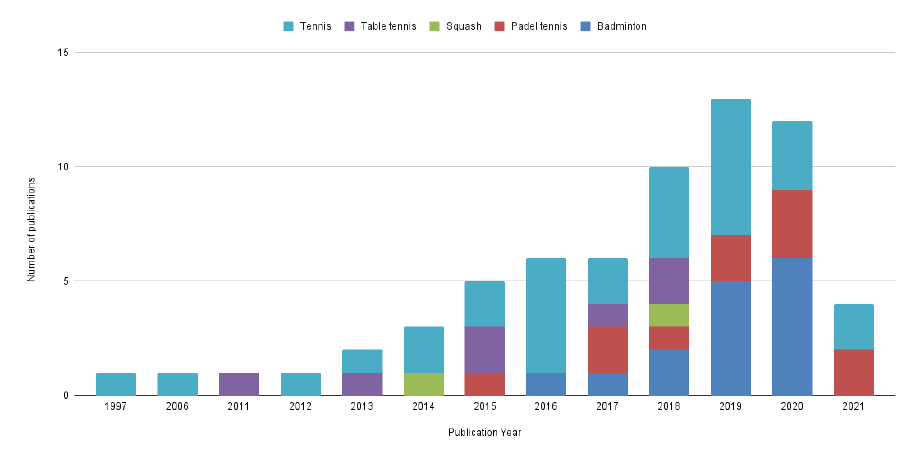
Figure 5. Year of publication, categorized by